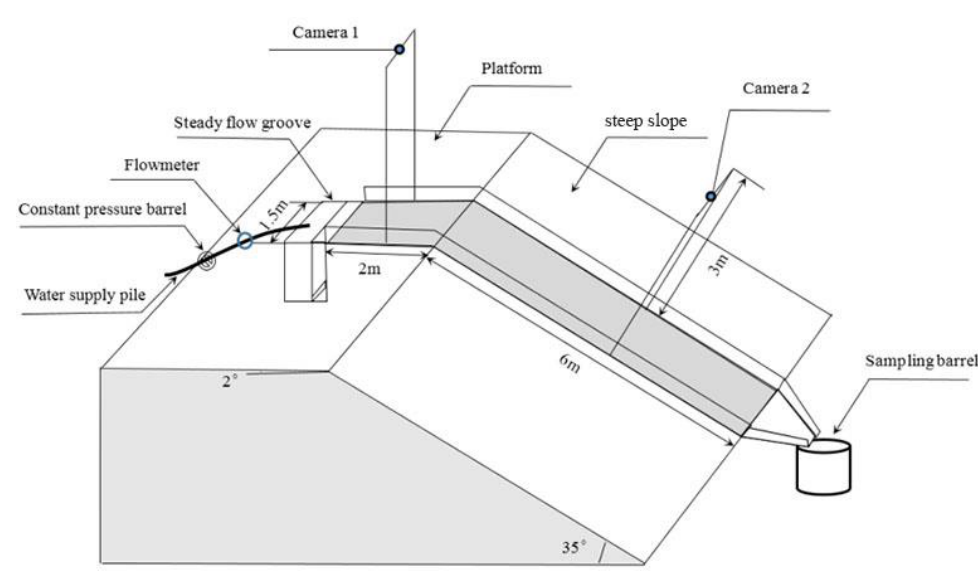
Figure 2. Runoff plot of platform-steep slope system.